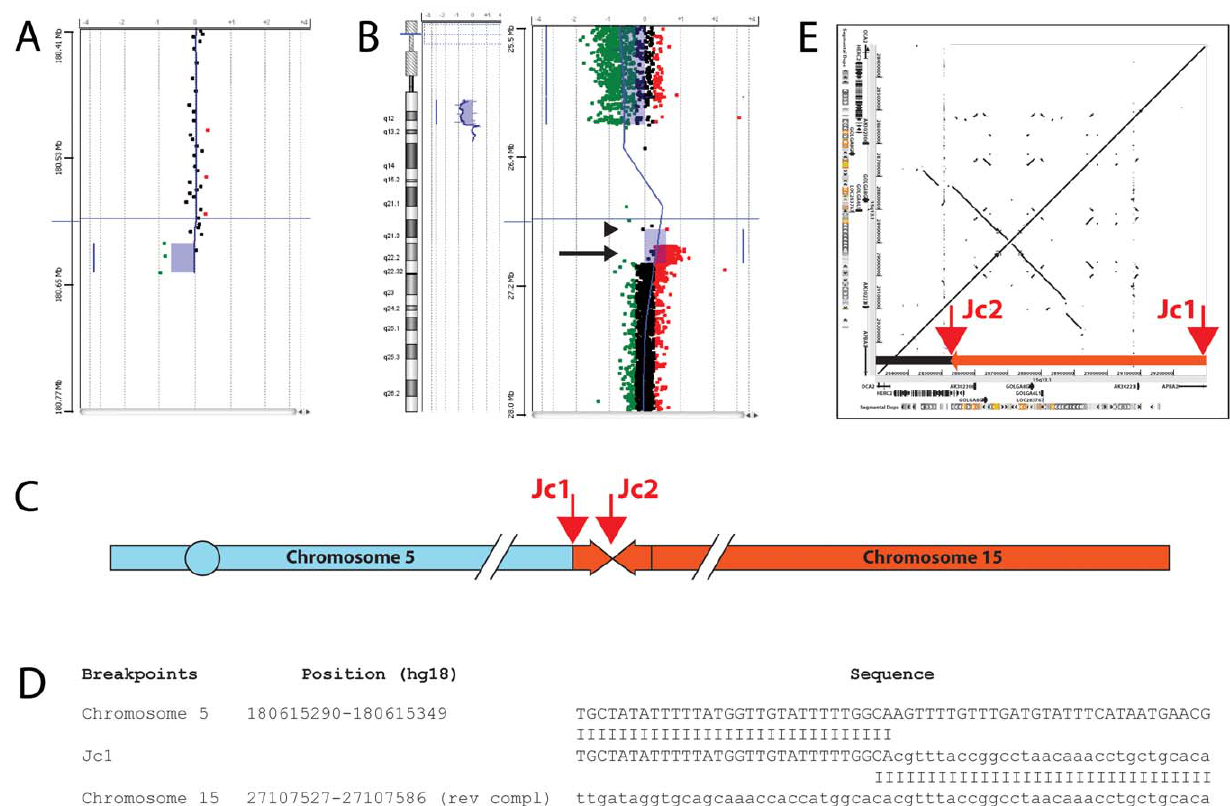
Figure 1. Molecular cloning of the 5;15 translocation in case 1. A, magnified view of the chromosome 5 breakpoint boundary detected by array-CGH using a 244 K oligonucleotide-based whole-genome microarray. The shaded area indicates a loss in DNA copy number (deletion) detected by three oligonucleotide probes (green dots). Black dots represent probes with no changes in copy number (non-deleted region). B, whole chromosome view (left) and magnified view (right) of the chromosome 15 breakpoint boundaries detected by custom oligonucleotide-based 15q11- q13 microarray. The shaded areas indicate a deletion (majority of green dots) and a gain in DNA copy number (duplication) detected by red dots (see arrow). The area containing few widely spaced probes represents BP3, a large region containing paralogous sequences. The last deleted oligomer is at 26,210,153 bp within HERC2 , corresponding to BP3; the duplicated region is between 26,996,914 (first duplicated) and 27,106,557 bp (last duplicated) with first normal oligomer at 27,108,882 bp just distal to BP3, within the APBA2 gene. An arrowhead points to the two black spots possibly indicating a single copy region between the deletion and the duplication. C, schematic representation of the rearrangement showing the two chromosomes involved, the position and orientation of the duplicated region, and the location of the two junctions (arrows). D, DNA sequences spanning the chromosome 5 deletion/15 duplication junction (Jc1) aligned with the reference sequences. E, dot-plot diagram, made with PipMaker software [45], showing the relative location of the inverted chromosome 15 duplication boundaries (Jc1 and Jc2, arrows) and of the GOLGA8E - associated inverted low copy repeat. The duplicated portion is represented by an orange arrow box.